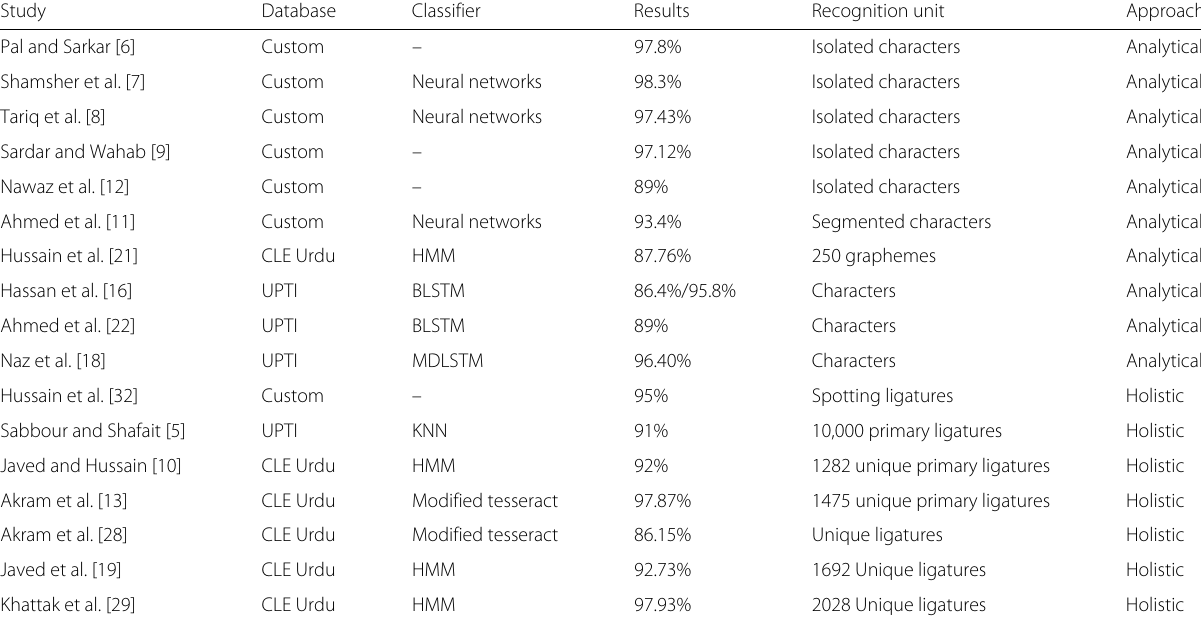
Table 1 A summary of notable contributions on recognition of Urdu text